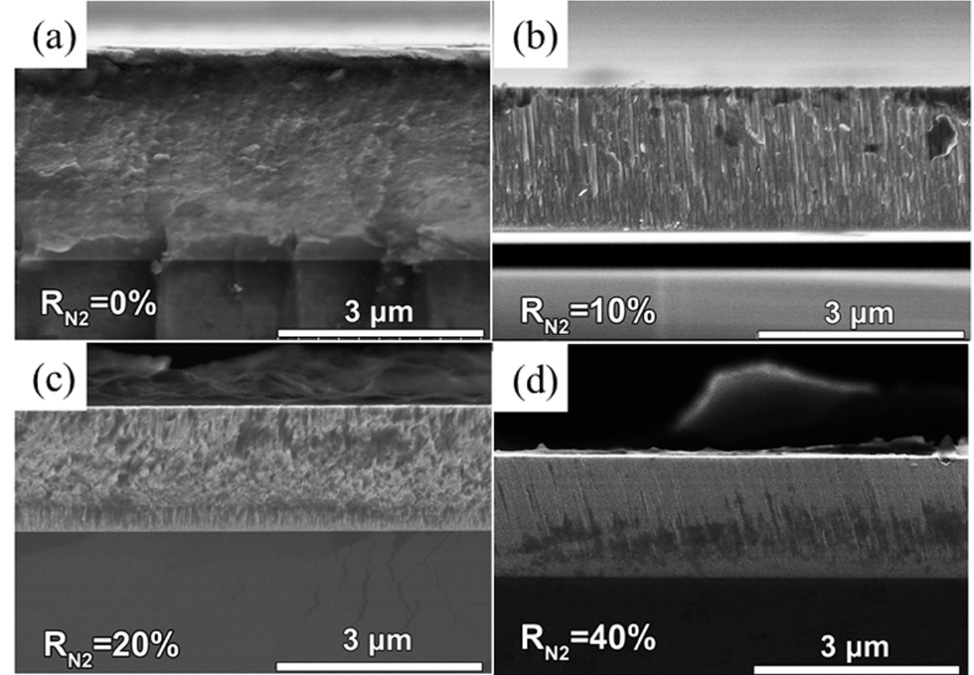
Figure 8. Cross-sectional SEM image of AlTiTaZrHf(N) films as a function of R N2 : ( a ) R N2 = 0%; ( b ) R N2 = 10%; ( c ) R N2 = 20%; ( d ) R N2 = 40% [66].